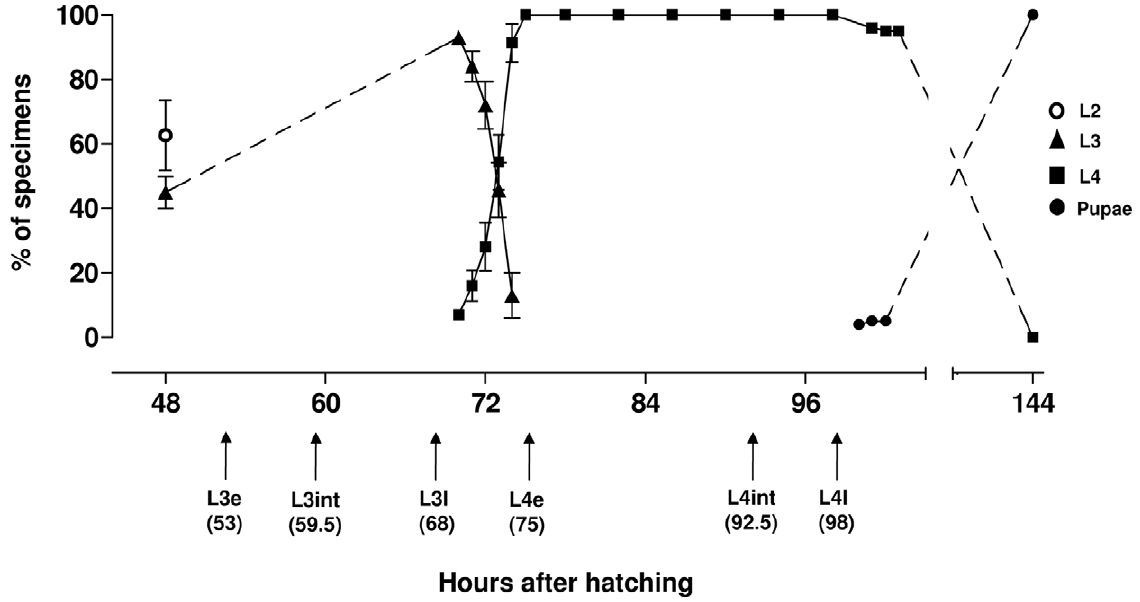
Figure 3. Period duration of Ae.aegypti larval ecdysis. Symbols represent the cumulative percentage of specimens at different immature stages. Bars represent the standard deviation of three independent experiments. Arrows indicate the experimental points, defined in hours, as early (e), intermediate (int) and late (l) moments for each instar.